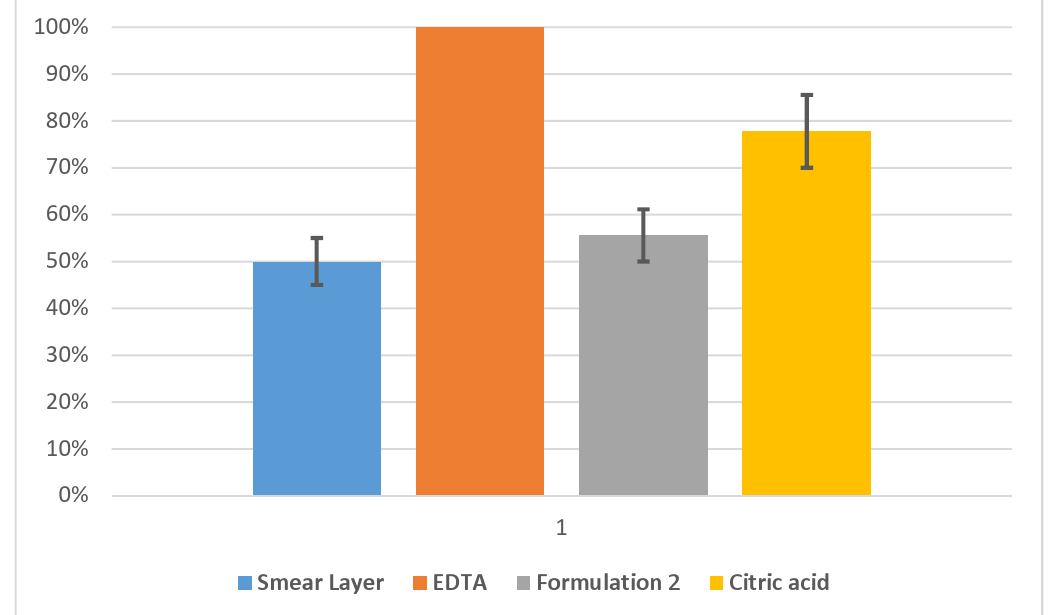
Figure 2. Normalized permeability for model dentine samples treated with formulation 2 (66% nano-apatite based cement + 27.2% glycerin + 6.8% PEG 200) measured after the formation of the smear layer (blue) and EDTA (orange), formulation 2 (grey) and citric acid (yellow) treatments. Statistical variation of 20 independent measurements is reported as black bars.